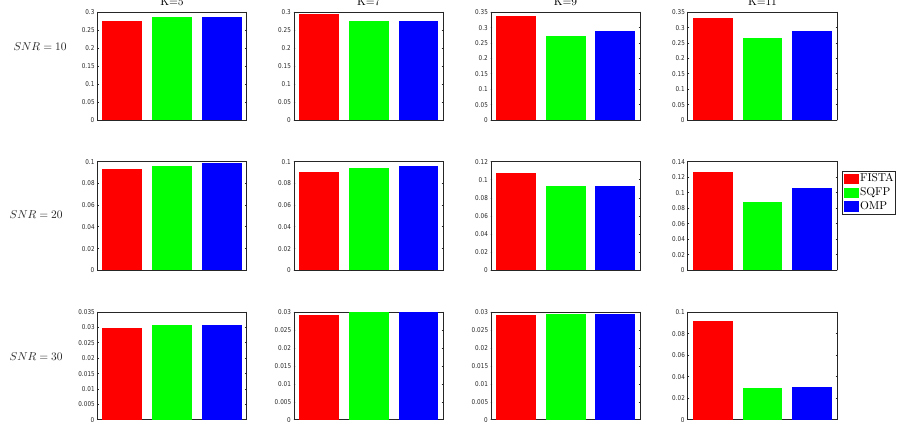
Figure 6. Mean errors for all algorithms, dictionary size 80 × 200, condition number